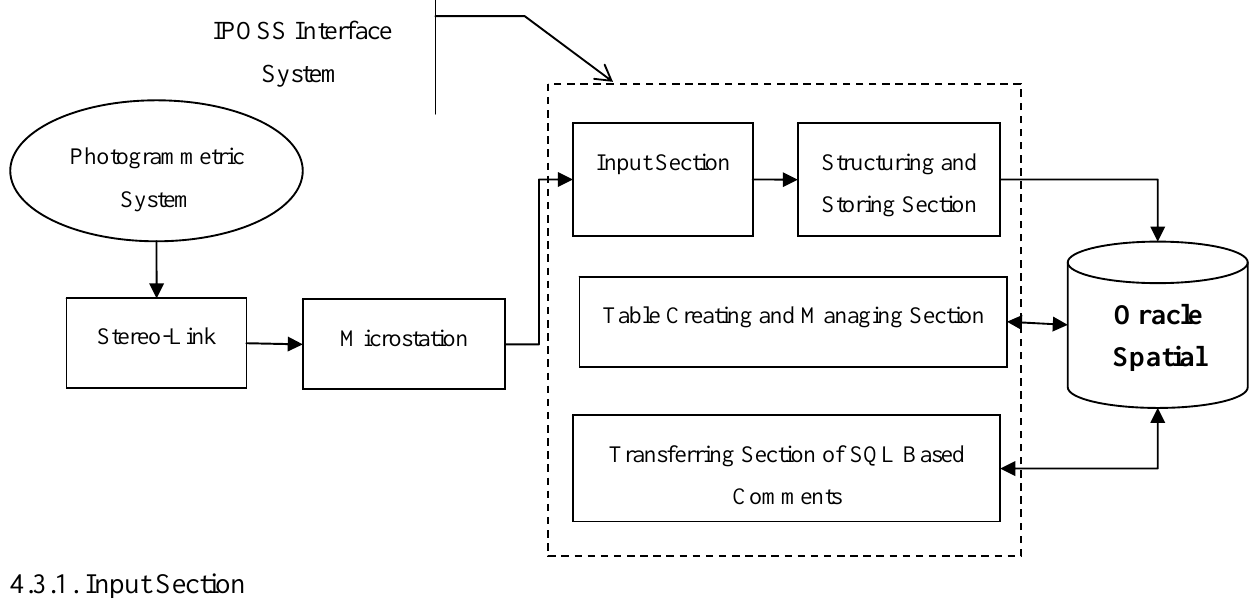
Figure 2. Main structure of the interface system